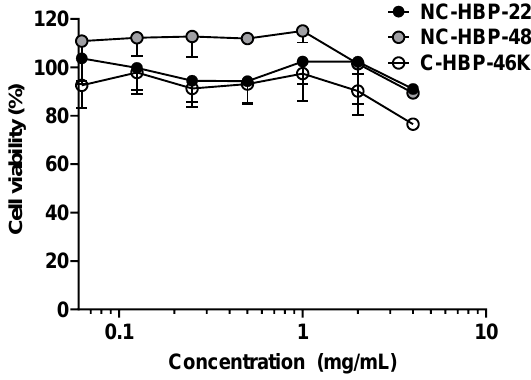
Figure 2. Cytotoxicity profile of hyperbranched polymers at various concentrations against MDA-MB-231 cells over a 72 h incubation period. Values are represented as mean ± SD ( n = 3).